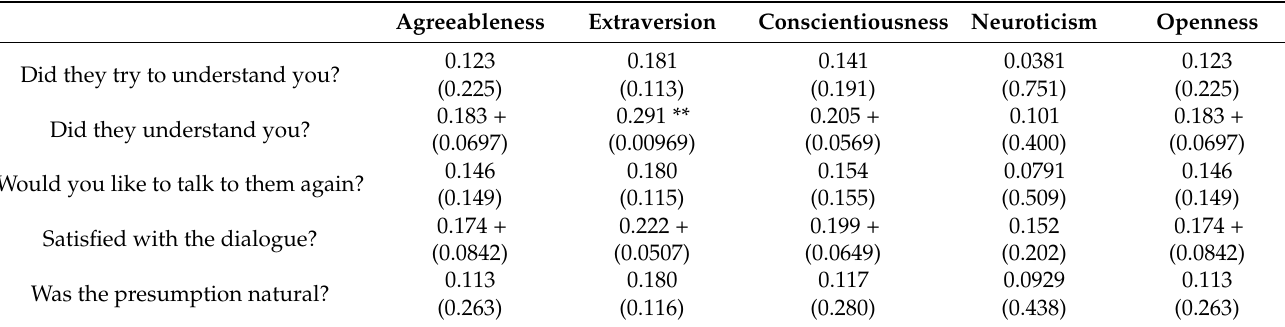
Table 13. Correlation coefficients between the information content for the estimated items and the questionnaire